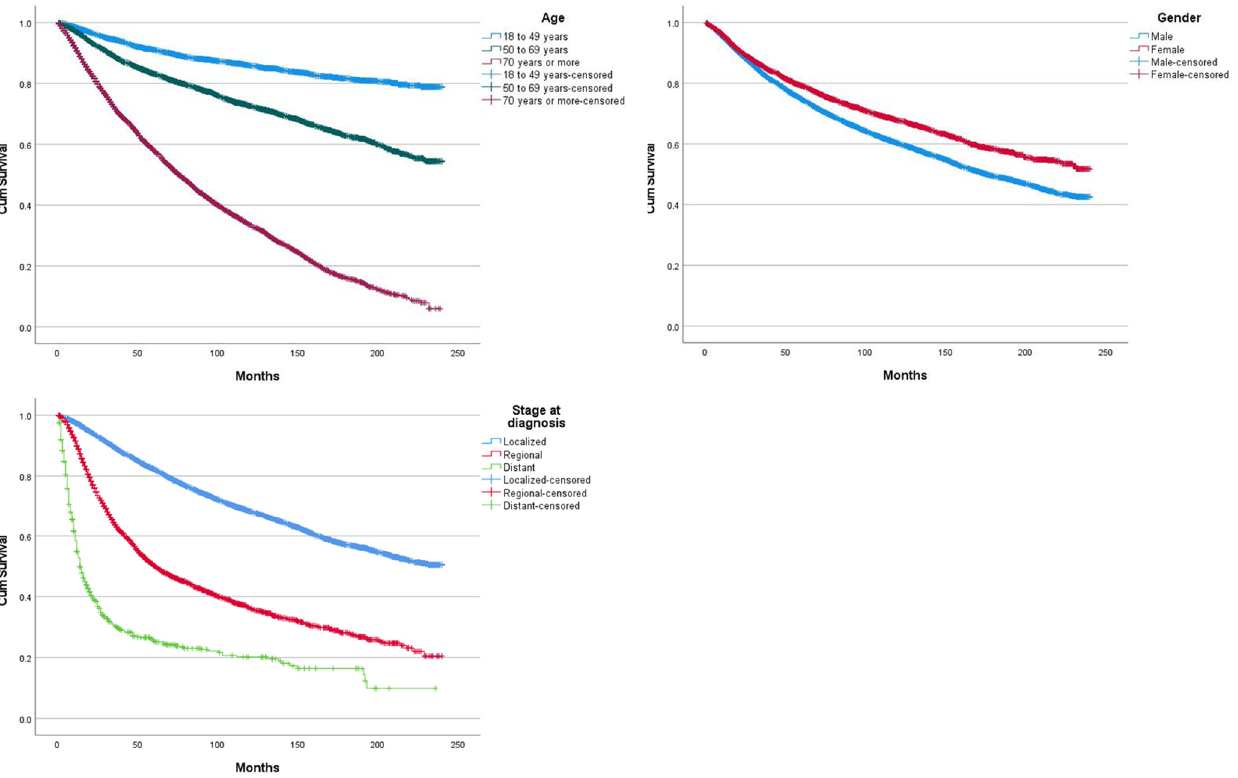
Figure 1. Overall survival curves, according to age, gender, and stage at diagnosis.